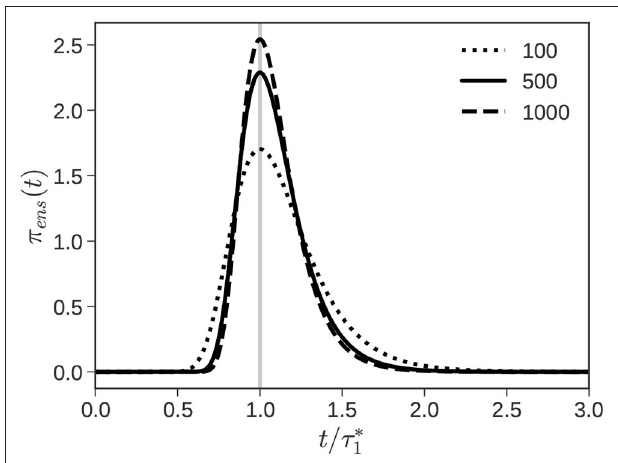
FIGURE 3 | Reequilibration. The PDF (Equation 13) from which the RE time T re is sampled narrows as the number of chains n 1 increases from 100 to 1,000.